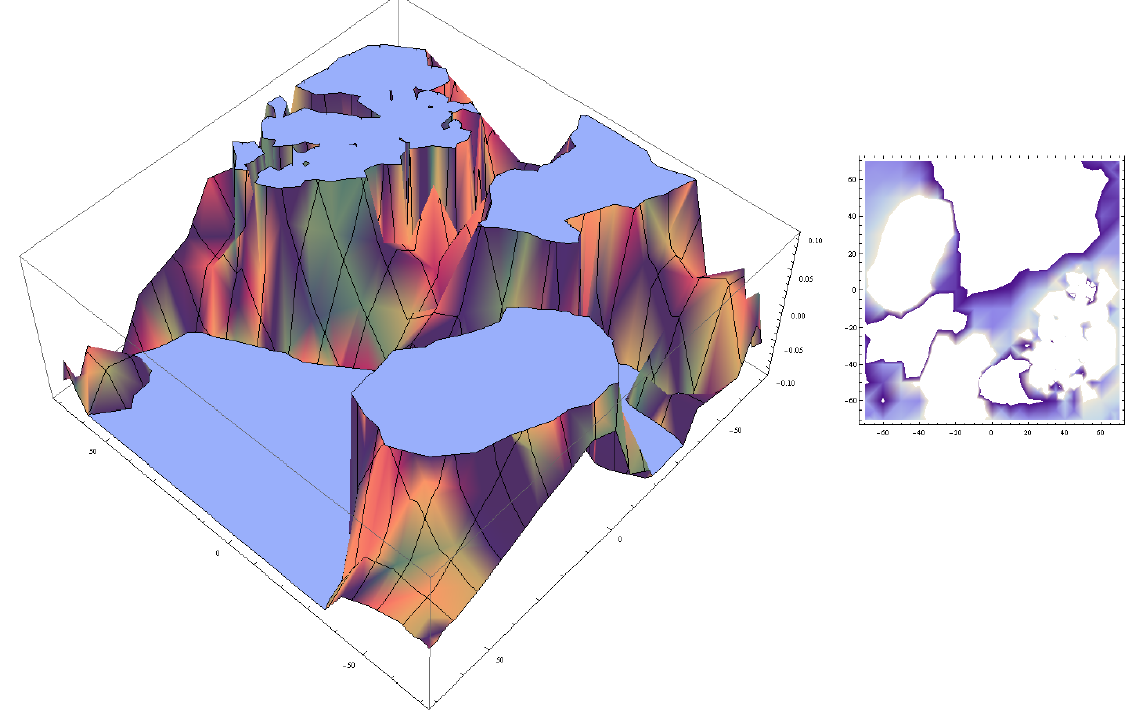
Figure 1: The adaptational landscape, which was constructed on the basis of reference points of the experimental data. The left section presents convolution to the three-dimensional image. The right section presents the space for determination of the function, which would comply with the target indicators of the concrete strength, which were prescribed at the input of the metaheuristic algorithm. Table 2: The proposed proportions of the composition, which were obtained on the basis of the metaheuristic optimisation. Desired